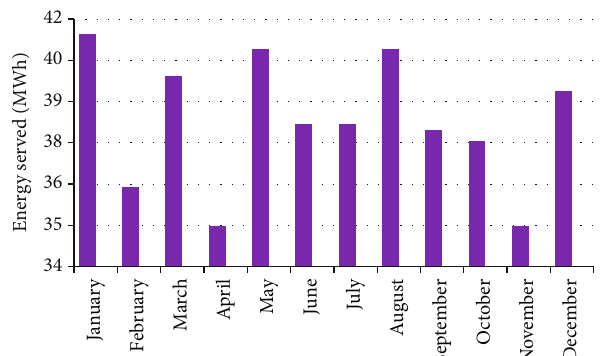
Figure 12: Energy served (MWh), monthly energy served to the managed